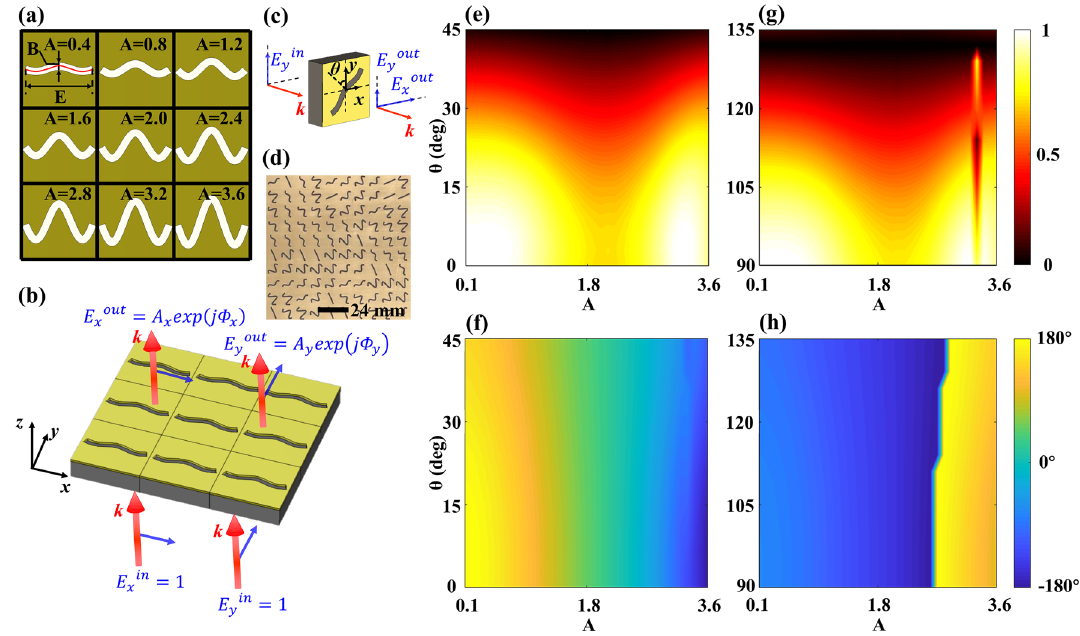
Figure 3: Schematic diagram of meta-atoms. (a) Top view of the designed meta-atoms, where the red curve indicates the curve corresponding to the function y = A cos(0.86 x ), B = 1.2 mm, and E = 10 mm. Different values of A correspond to different element shapes. (b) The designed meta-atom produces different transmittance and phase shift between two electric fi eld vectors respectively parallel to the fast axis and the slow axis. (c) When the y -polarized electro- magnetic wave is normally incident, the amplitude and phase of the cross-polarized electromagnetic wave can be regulated by changing the rotation angle θ and A of the element. (d) The fabricated sample of the designed meta-atoms. The cross-polarization transmission amplitude and phase characteristics of different shaped elements when the variation range of θ is 0 ° ∼ 45 ° (e, f) and 90 ° ∼ 135 ° (g, h),